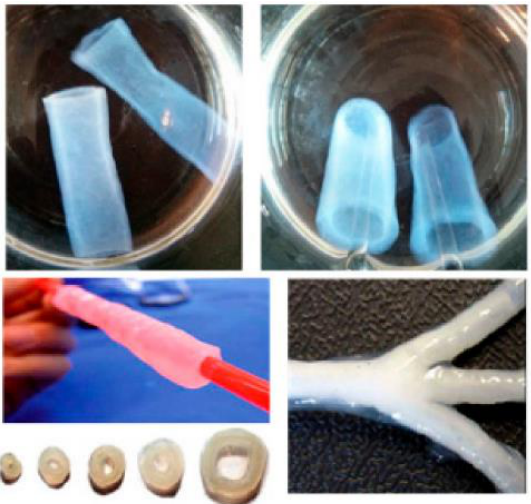
Figure 6. Vascular graft and blood vessel tubes with different sizes and shape, produced by fermen- tation onto a branched silicone tube [6].